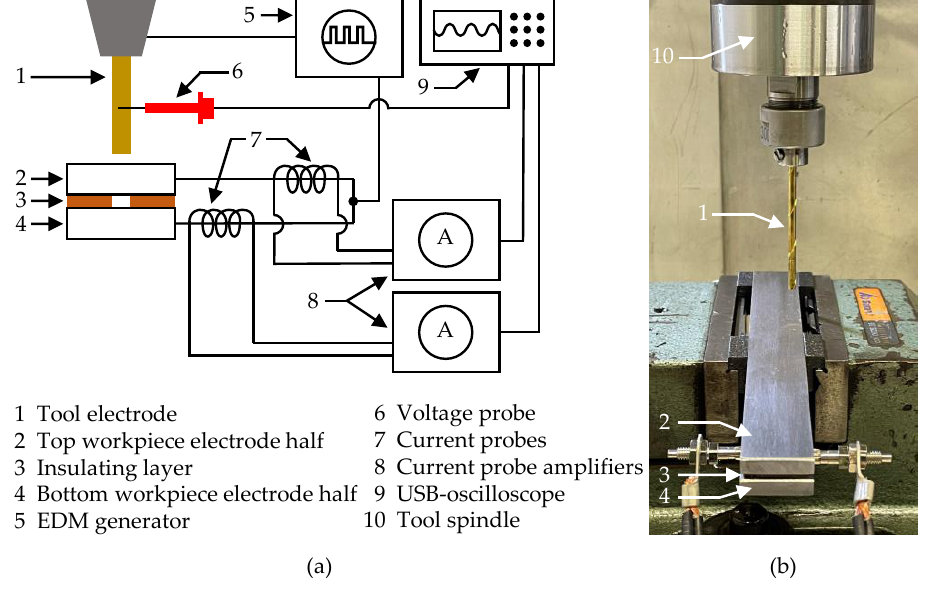
Figure 2. ( a ) Schematic setup and ( b ) experimental setup used for signal analysis [20].